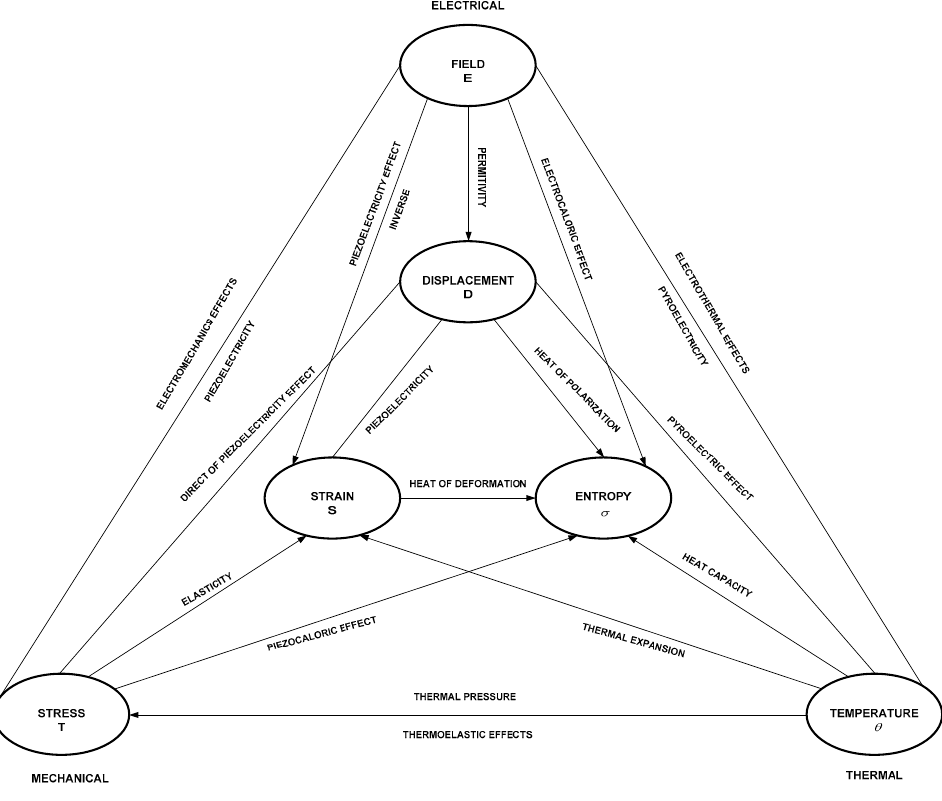
Figure 4. Heckmann’s piezoelectricity diagram